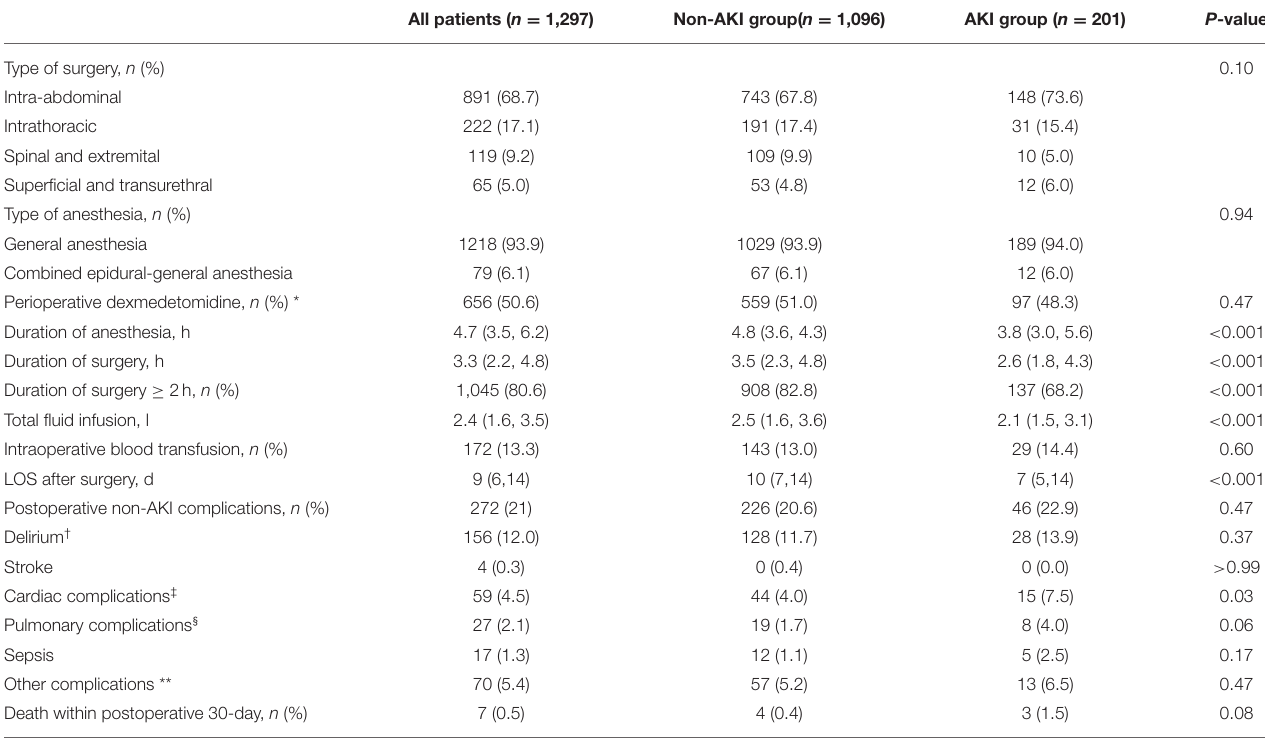
TABLE 2 | Perioperative variables.